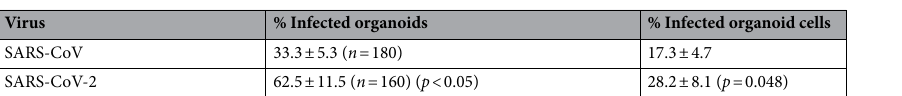
Table 1. Infection of liver organoids with SARS-CoV-2 and SARS-CoV. n total number of organoids